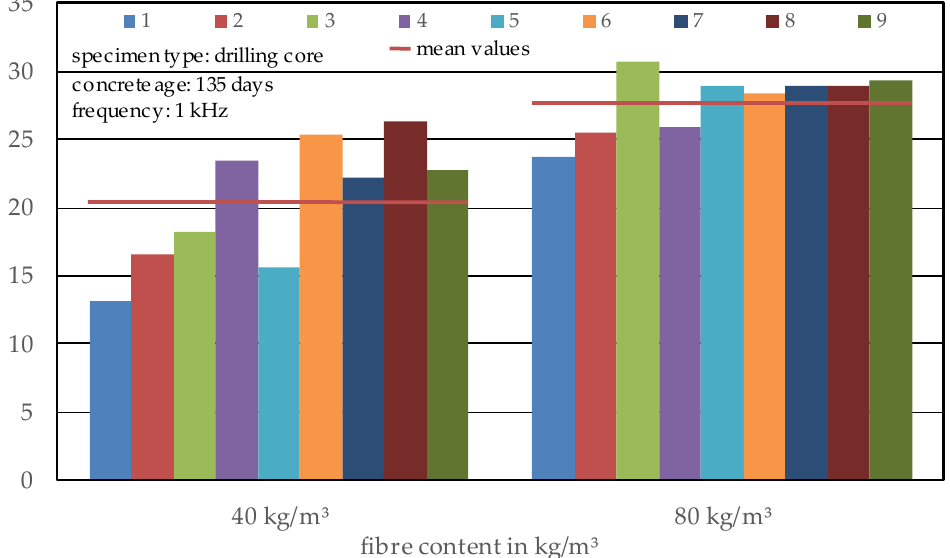
Figure 14. Calculated fibre content of the drilling cores as a function of the actually added fibre